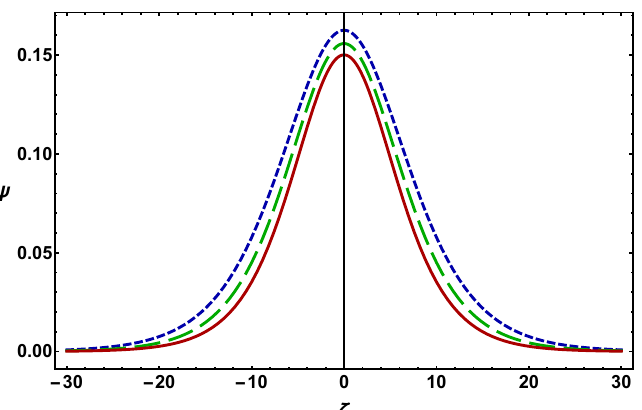
Figure 6. The effect of inclination angle of rotation of plasma system on NA wave potential ψ in degenerate non-relativistic plasmas by considering θ = 2 ◦ (blue dotted curve), θ = 4 ◦ (green dashed curve), and θ = 6 ◦ (red solid curve) when Ω 0 = 0.03, Ω c = 0.05, l x = 0.2, σ e = 0.1, σ Te = 0.1, and δ = 0.3.